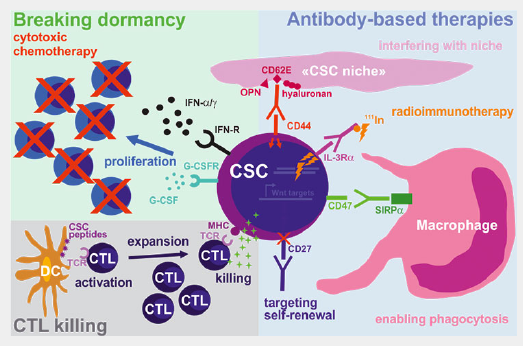
Targeting cancer stem cells (CSCs) using immunotherapy. As compared to the bulk of tumour cells, CSCs may also be targeted using antibody-based therapies by blocking pathways important for homing and engraftment (CD44), self-renewal (CD27), protection against phagocytosis (CD47) and by delivering radioactive compounds (IL-3Rα). In addition, strongly activated and expanded cytotoxic CD8 + T cells (CTLs) specific for CSC antigens are promising candidates for a potent and long-lasting elimination of CSCs. Finally, forcing CSCs into the cell-cycle by breaking their dormancy using proliferation-activating molecules, followed by conventional cytotoxic chemotherapy, may represent an attractive two-step strategy to eradicate